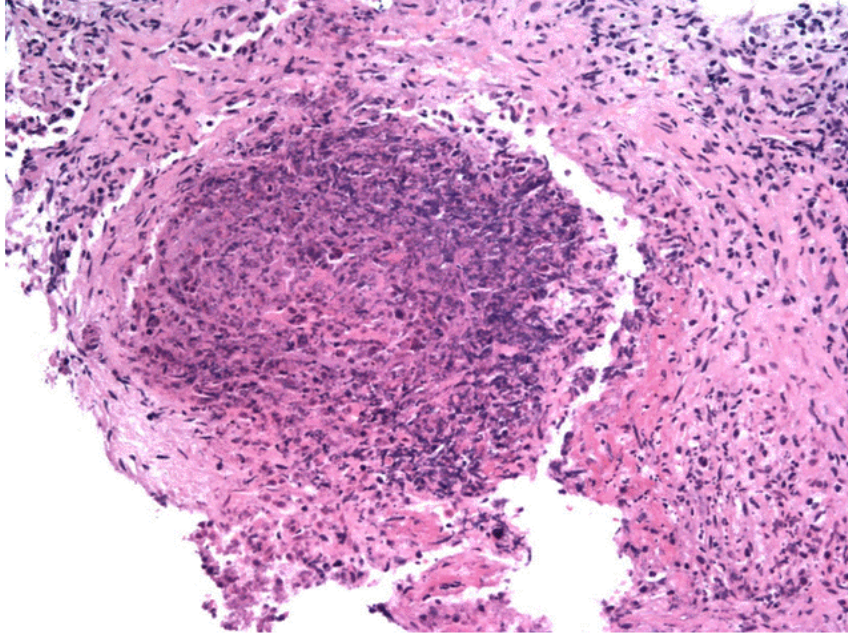
FIGURE 1. Wedge lung biopsy. Chronic inflammation and necrotic debris, consistent with a necrotizing granulomatous process (H&E, original magnification  400).